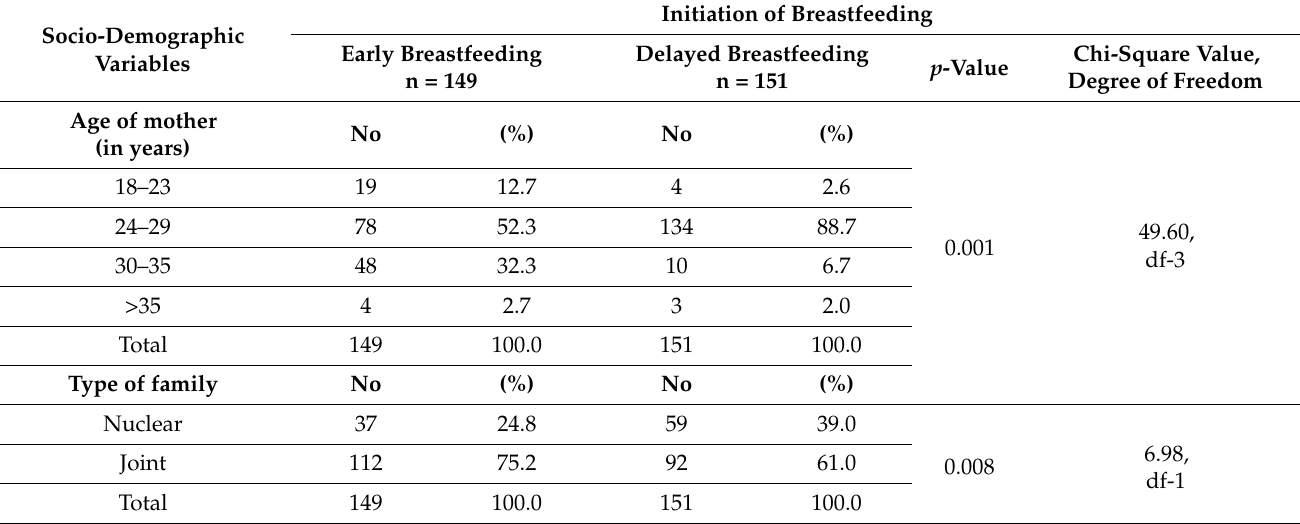
Table 4. Socio-demographic factors influencing Initiation of